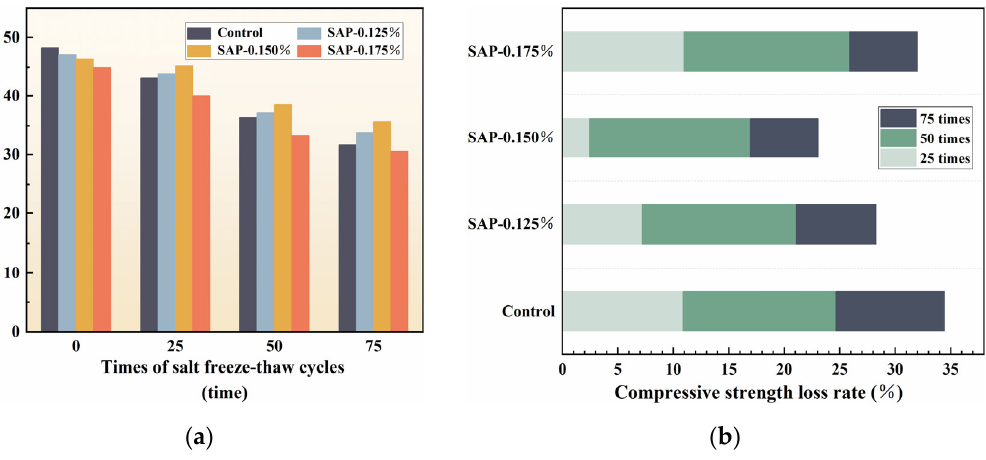
Figure 6. Variation of compressive strength and compressive strength loss rate with salt freeze–thaw cycles times: ( a ) Compressive strength; ( b ) Compressive strength rate.